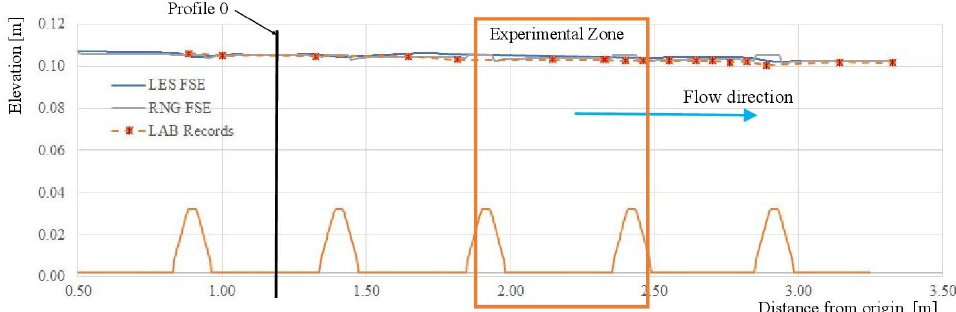
Figure 3. Comparison of the computed and recorded values in the laboratory (FSE).